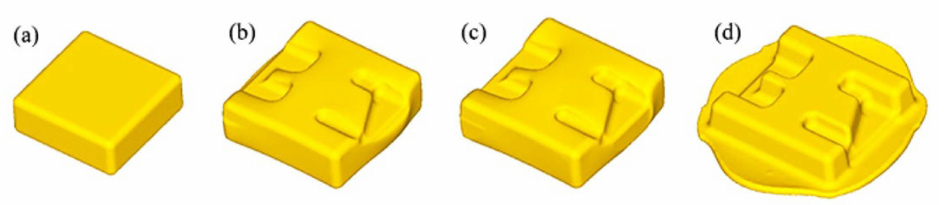
Figure 5. Schematic diagram of forming process: ( a ) blanking, ( b ) pre-forging, ( c ) trimming, and ( d ) final forging.